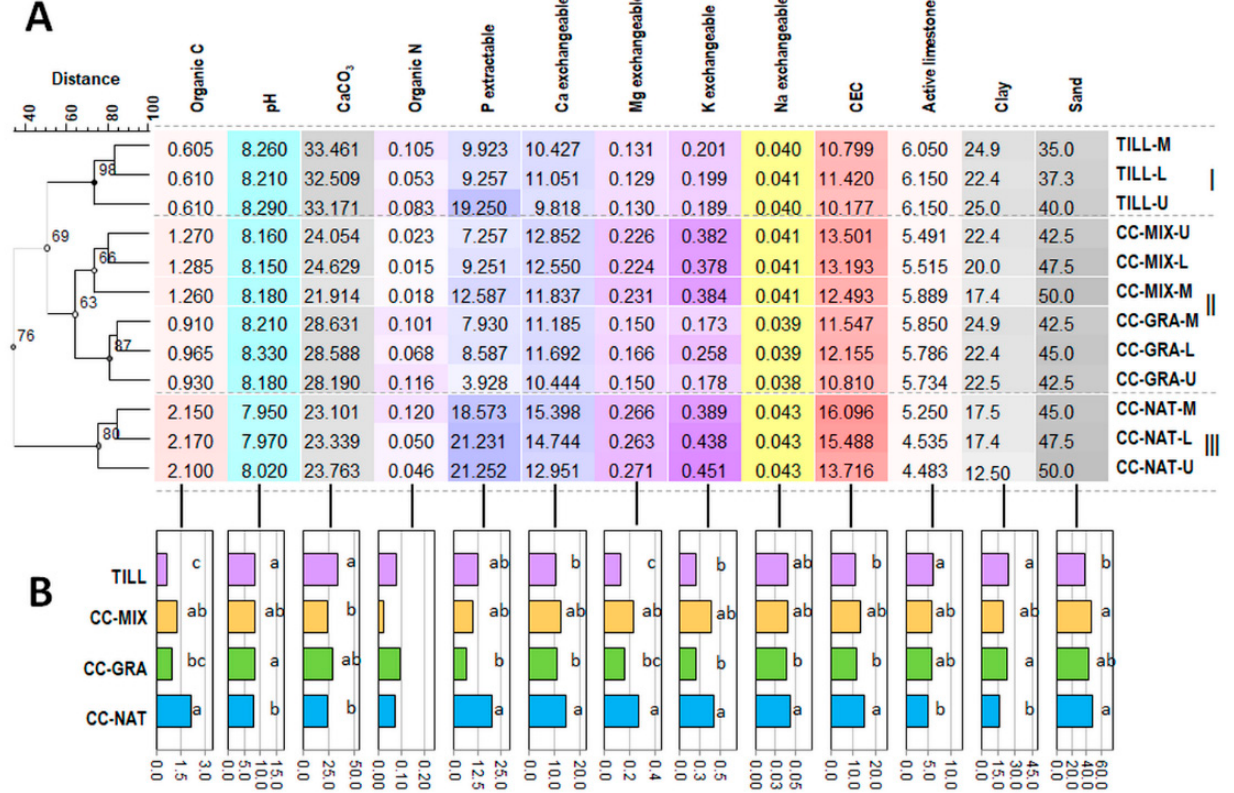
Figure 1. Soil physicochemical properties of an olive orchard soil under different cover crop managements (TILL: tillage, CC-GRA: sown cover crop with gramineous and CC-MIX: sown cover crop with a mixture of species) and CC-NAT (cover crop with spontaneous vegetation) and for each sampling point on the slope (U: upper, M: middle and L: lower). ( A ) The cluster analysis using the Ward algorithm applied to the similarity matrix generated from the numerical values of each variable by using the Bray–Curtis distance coefficient. The intensity of color in the figure is proportional to the activity. Cophenetic correlation values are indicated in each node. ( B ) The mean comparison of each individual physicochemical property using the rank-based Kruskal–Wallis test. All-pairwise multiple comparison test was applied when appropriated. (Different letters indicate significant differences p < 0.05).